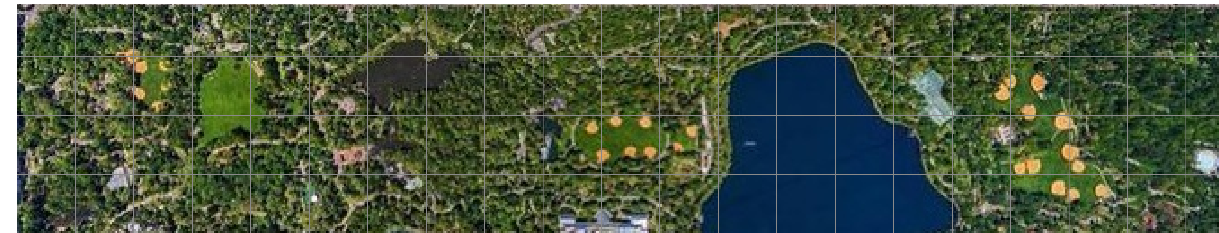
Figure 8. Example of outdoor environment.